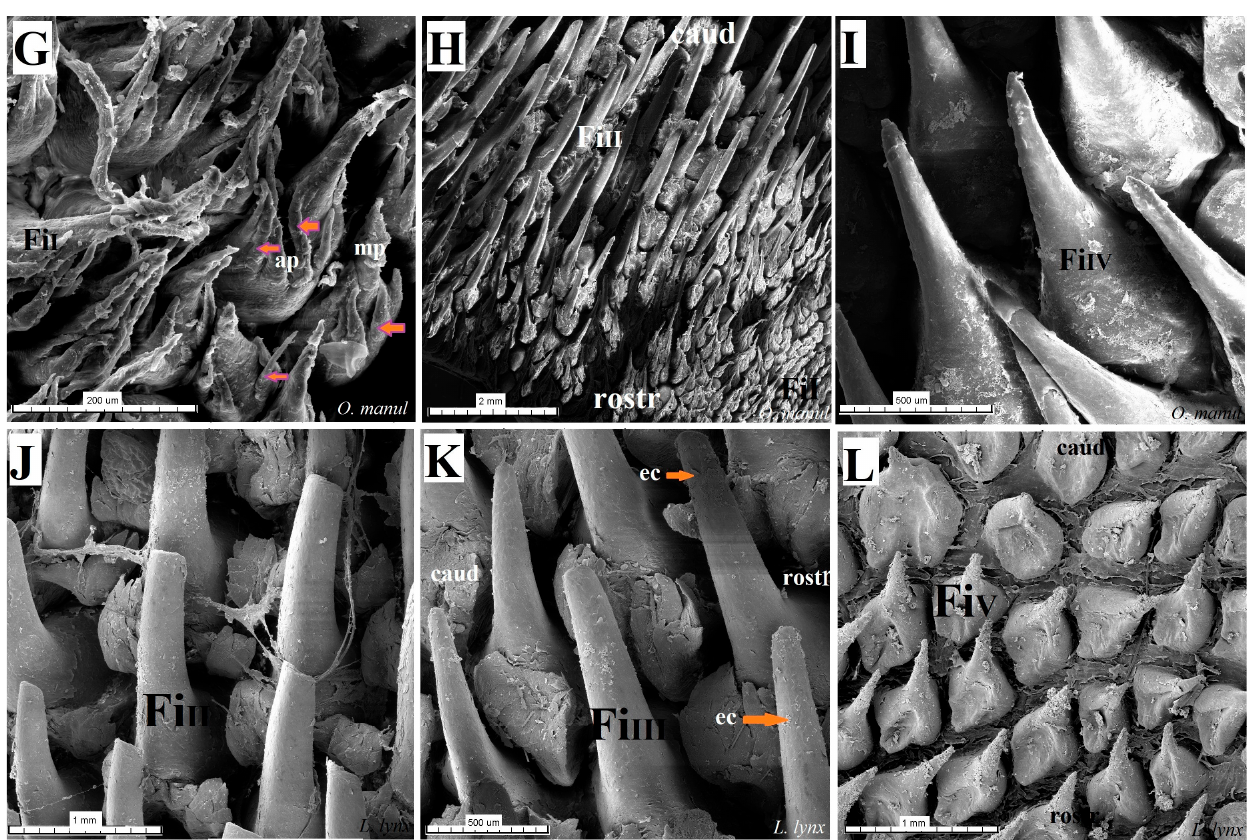
Figure 16. Scanning electron microscopic (SEM) pictures of the filiform papillae of the tongue of the four undomesticated species of Felidae: N. nebulosa ( A – C ), P. leo bleyenberghi ( D – F ), O. manul ( G – I ) and L. lynx ( J – L ). ( A , B ) Filiform papillae subtype I and II between the apex and body of the tongue. ( C ) Filiform papillae subtype III from lateral part of the body of the tongue. ( D ) Largest filiform papillae subtype II with the best-developed anterior part of each papilla. ( E , F , I , K ) Filiform papillae subtype III without additional projections. ( G ) Small filiform papillae subtype I with main base of papillae and several additional projections on the anterior part of main papilla. ( H ) High filiform papillae subtype II between the apex and body of the tongue. ( J ) Largest filiform papillae subtype II. ( L ) Short filiform papillae subtype V between body and root of the tongue. Bar = 2 mm (A,B,D,E,H); bar = 1 mm (C,F,J,L); bar = 500 µm (I,K); bar = 200 µm (G). Abbreviations: ant—anterior part of the mechanical lingual papillae, ap—additional projection (purple arrows), caud — caudal orientation of the papillae, ec — exfoliated cell (orange arrow), Fi I —filiform papillae subtype I, Fi II — filiform papillae subtype II, Fi III —filiform papillae subtype III, Fi IV —filiform papillae subtype V, Fi V —filiform papillae subtype V, mp—main part of the lingual mechanical papilla subtype Fi I , rostr — rostral orientation of the papillae.